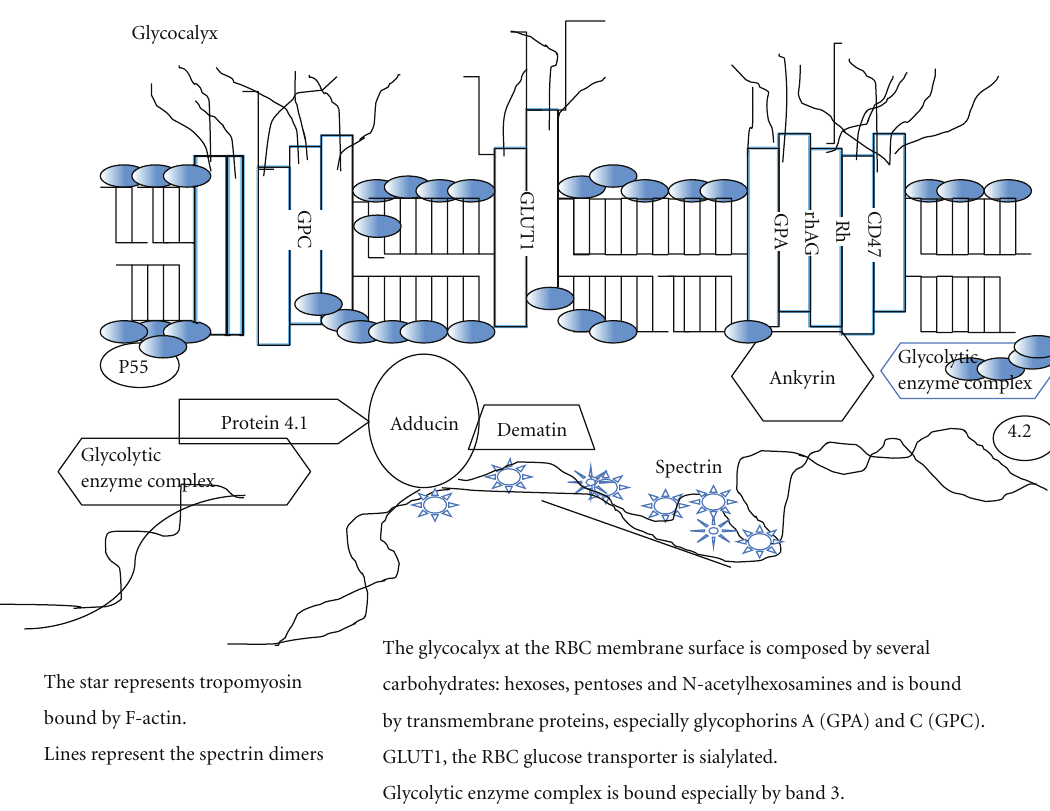
Figure 1: Schematic representation of the red blood cell